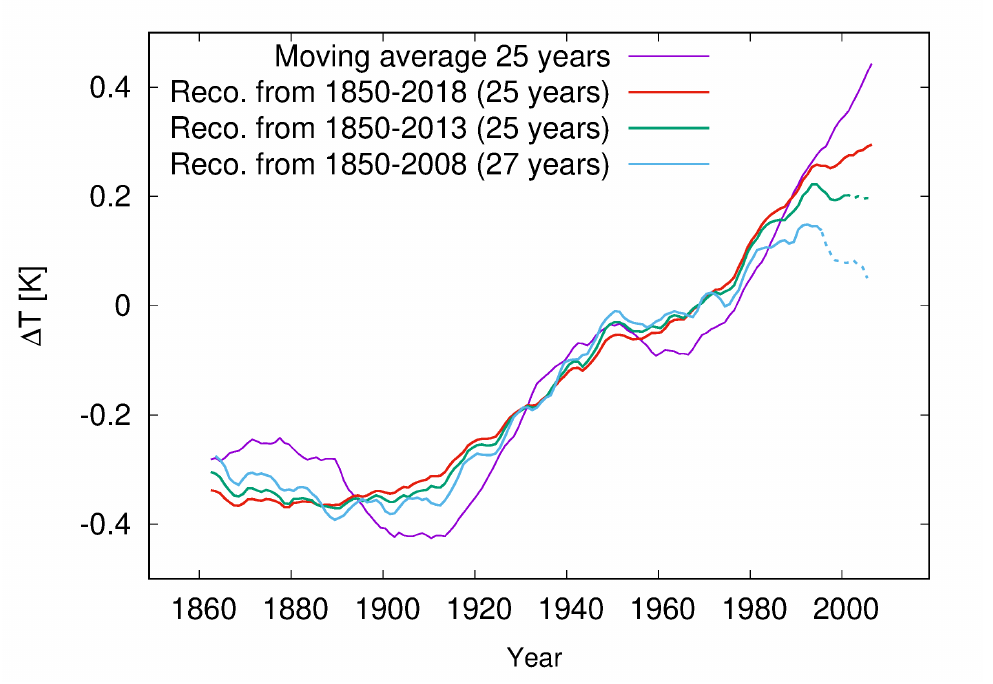
Figure 8. Original ∆ T data, averaged over 25 years and reconstructions based on the optimal combinations of w aa and w CO from Figure 7. The dashed segments of the green and blue curves 2 indicate the time intervals that did not enter in the respective regressions. From the red over green to blue curve, we see an ever improving reconstruction of the oscillatory behaviour, and an ever increasing divergence with the observed data at later